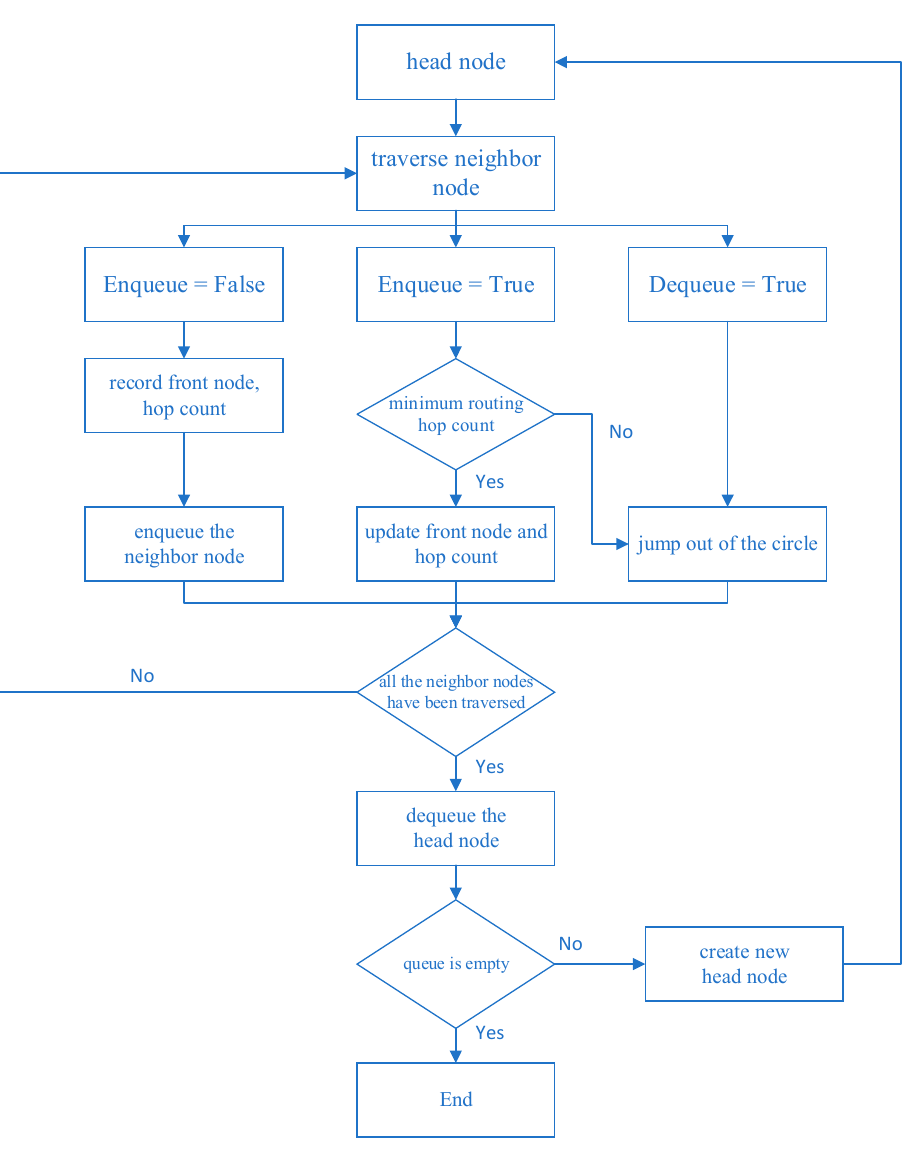
Figure 2. Flow chart of multipath algorithm.